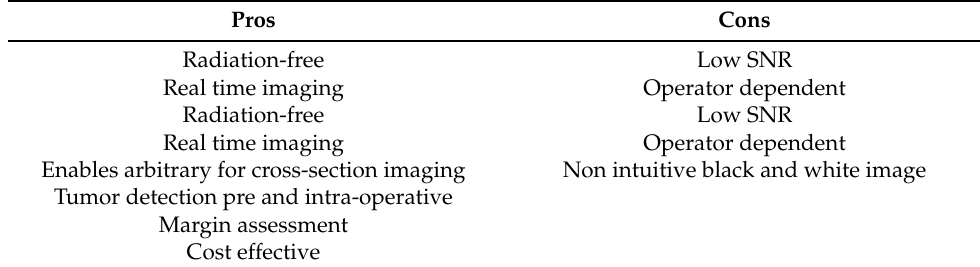
Table 1. Ultrasound imaging pros and cons associated with detection of tumors and their margins, pre-operatively and intra-operatively. Pros Cons Radiation-free Low SNR Real time imaging Operator dependent Radiation-free Low SNR Real time imaging Operator dependent Enables arbitrary for cross-section imaging Non intuitive black and white image Tumor detection pre and intra-operative Margin assessment Cost